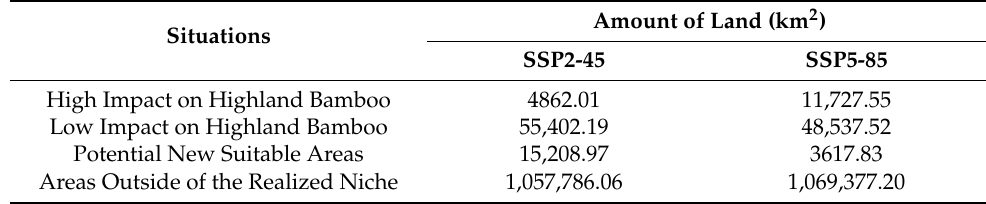
Figure 6. Impact of climate change on habitat niche suitability of highland bamboo under medium forcing scenario (SSP2-4.5). Table 3. Situational analysis of the impact of climate change on the distribution of highland